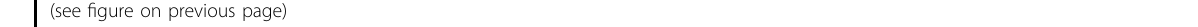
Fig. 5 Inhibition of KRAS(G12D) mutant cell lines by TH-Z827 and TH-Z835. a Viability assays of PANC-1 and Panc 04.03 cells treated with indicated concentration of TH-Z827 or TH-Z835 for 24 h. b Immunoblotting analysis of ERK and AKT phosphorylation status in PANC-1 (left panel) and Panc 04.03 cells (right panel) treated with TH-Z827 for 3 h. c Immunoblotting analysis of ERK and AKT phosphorylation status in PANC-1 cells treated with TH-Z835 for 3 h. d Immunoblotting against RTK signaling and cell cycle marker proteins in PANC1 cells after 3-, 12- or 24 h treatment with the indicated concentrations of TH-Z835. e Percentages of KPC cells in the G1, S, and G2 phases after treated with TH-Z835 for 24 h (G2 phase on the top, less than 2%). Data are shown as means ± SEM. n = 3, two-tailed Student ’ s t -test, **** P < 0.0001. f Immunoblotting of EGFR, ERK, AKT phosphorylation, cleaved PARP (cPARP), cleaved Caspase-3 (cCasp-3), and cleaved Caspase-7 (cCasp-7) in PANC-1(left panel) and KPC (right panel) cells treated with TH-Z835 (5 μ M).